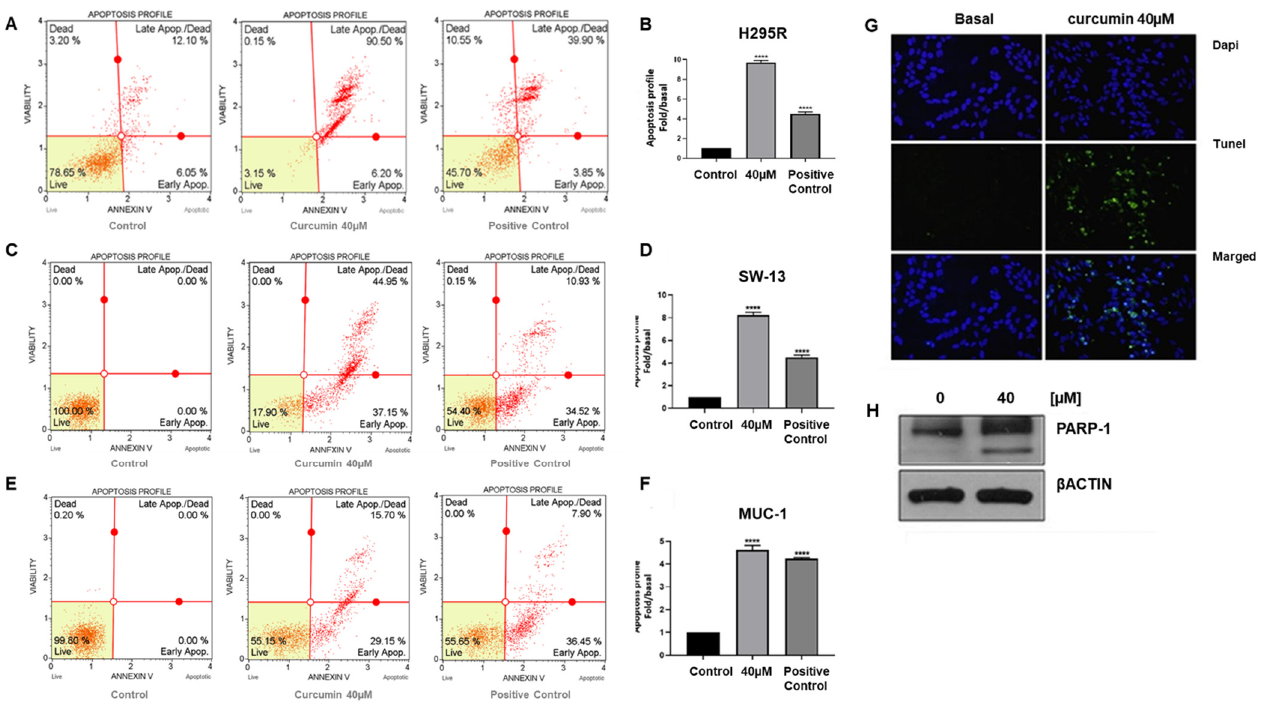
Figure 2. Curcumin induces apoptosis in ACC cells. H295R, SW ‐ 13 and MUC ‐ 1 cells were treated with curcumin (40 μ M) for 24 h and then labeled with Annexin ‐ V for flow cytometry analysis. Cytograms with Annexin V positive cells are shown in ( A , C , E ). Positive control is also included. ( B , D , F ) Graphical presentation of Annexin V positive cells. Data are expressed as the mean ± SE of three independent experiments, each performed in triplicate (**** p ‐ value < 0.0001 vs. control). ( G ) Representative images from TUNEL assay of H295R cells treated for 48 h with curcumin; DAPI was used for nuclei staining. Magnification 200X. ( H ) Western blot detection of cleaved PARP ‐ 1 protein from H295R cells treated for 24 h with curcumin. β ACTIN was used as a loading control. Blots are representative of three independent experiments with similar results.